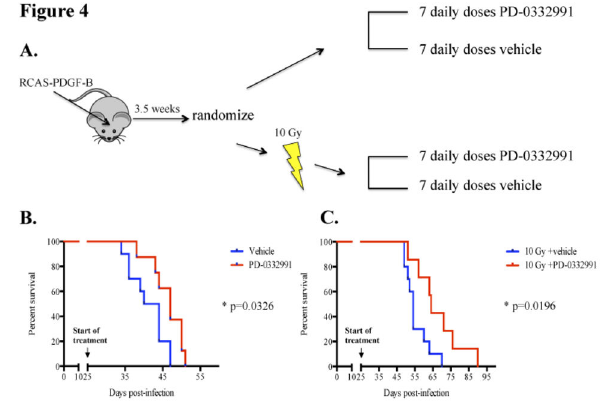
Figure 3. PD-0332991 induces a cell cycle arrest in the PDGF-B driven Ink4a-ARF deficient BSG model. (A) Cell cycle analysis of two independent Ink4a-ARF deficient BSG cell lines shows a significant increase in the percentage of cells at G0/G1, indicating cell cycle arrest, after 48 hours of treatment with PD-0332991. Table in the middle panel shows the mean of three independent experiments with two cell lines. A cell cycle analysis tracing (right panel) shows minimal apoptotic activity at 2µM. (B & C) Tumor bearing mice were given two treatments of PD-0332991 or vehicle, once daily by oral gavage (150mg/kg), and sacrificed 24 hours later. Brains were formalin fixed and paraffin embedded. (B) Representative phospho-histone 3 (pH3) staining, a marker for M phase, shows higher levels of proliferating cells in vehicle treated mice (left panel) as opposed to PD treated mice (right panel). (C) Quantification of immunostaining comparing the % pH3 positive nuclei/total nuclear area using MetaMorph Image Analysis Software. Statistics were done using a Mann-Whitney test and horizontal bars represent mean with SEM.